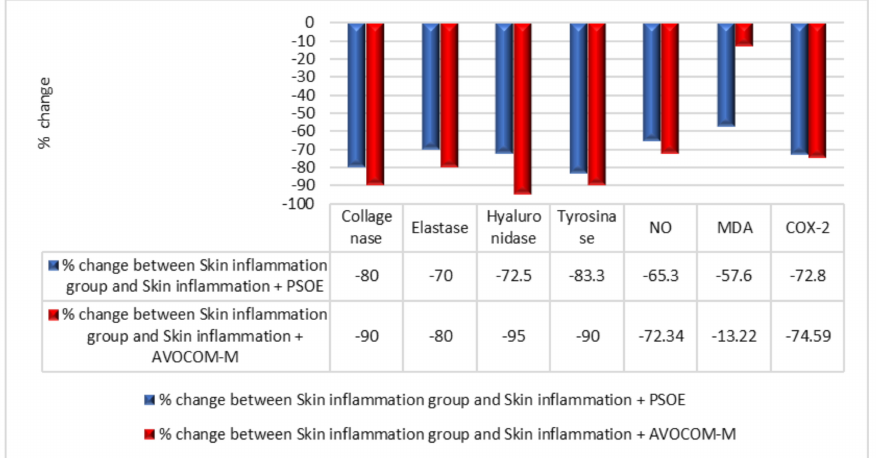
Figure 3. Comparison of beneficial effects of pomegranate seed oil extract (PSOE) and Avocom-M treatment in animal skin investigations. Collagenase, elastase, hyaluronidase, tyrosinase, nitric oxide (NO), malondialdehyde (MDA), and cyclooxygenase2 (COX-2) levels in five rat groups were compared in terms of percentage change between the skin inflammation + PSOE group and skin inflammation group, and between the skin inflammation + Avocom-M and skin inflammation